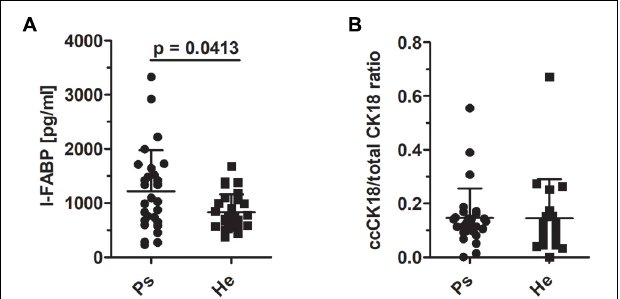
FIGURE 5 | I-FABP levels and the ratio of cytokeratin 18 and caspase-cleaved cytokeratin 18 in sera. (A) The comparison of the levels of I-FABP ( p = 0.0413, Mann–Whitney test) and (B) ccCK18/total CK18 ratios in psoriatic patients and healthy controls ( p = 0.5034, Mann–Whitney test). Disease status: Ps, psoriatic patient; He, healthy